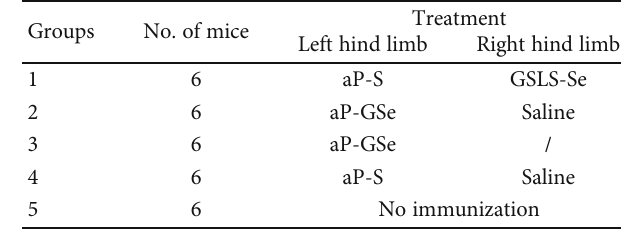
Table 1: Sequences of primers for quantitative RT-PCR of transcription factor.